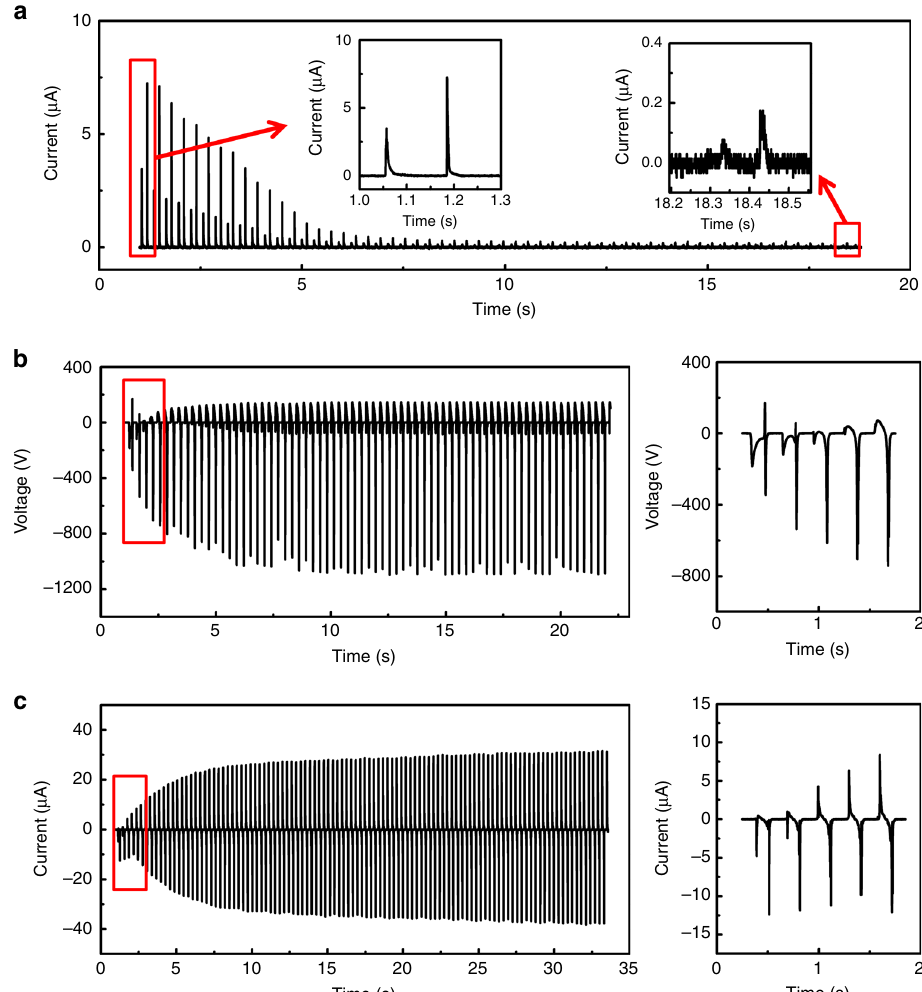
Fig. 2 Charge accumulation process of the self-improving triboelectric nanogenerator. a The current measured at the positive pole of the recti fi er bridge shows the charge generated by the voltage source fi lled into the plane-parallel capacitor structure (PPCS). Output voltage ( b ) and current ( c ) of the self- improving triboelectric nanogenerator (SI-TENG) increase with charge accumulation in the